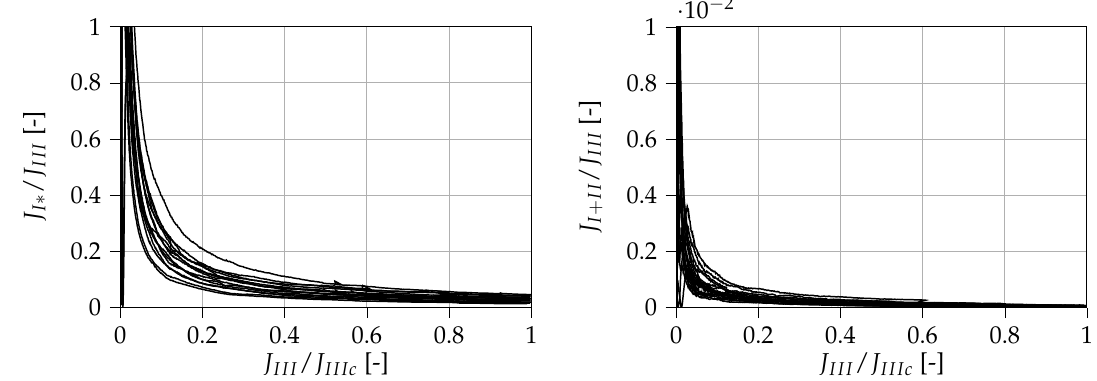
Figure 13. Artificial contributions determined within the mode III investigation. The unintended out-of-plane mode I load J I ( left ) and the mode I/II contribution J I + II ( right ) are displayed normalized ∗ on J IIIc over J III / J IIIc